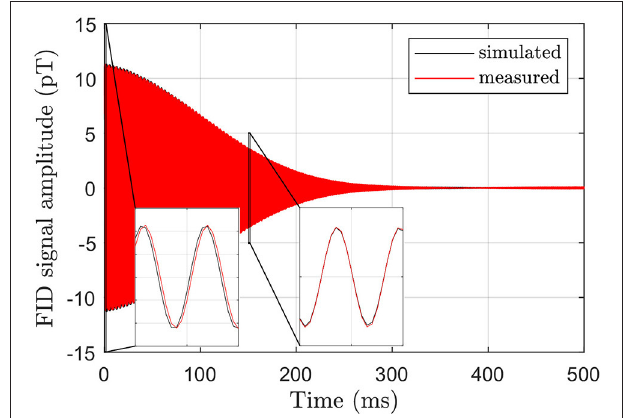
FIGURE 4 | Comparison of simulated and measured FID signals for dephasing in the static field B 0 = 38.6 µ T and the gradient dB x / dx = 2.4 µ T/m. The insets show close ups from 0 to 1 ms and from 150 to 151 ms, respectively, and reveal a small field drift of ∼ 15 nT in the measured FID compared to the simulation which assumes a constant B x ( r